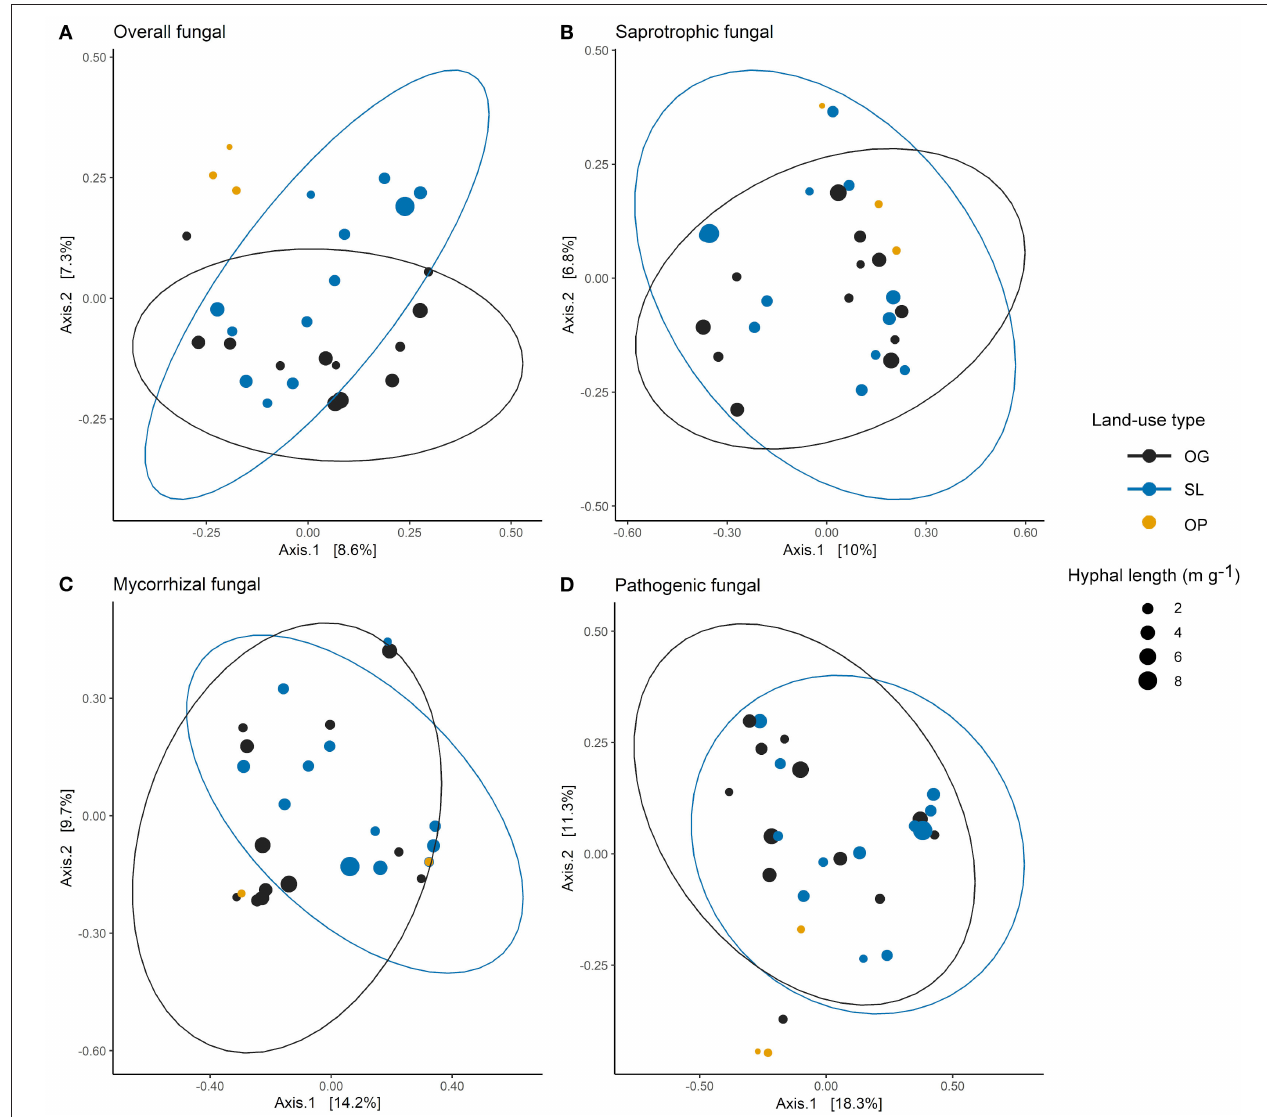
FIGURE 2 | Principle coordinates analysis (PCoA) ordination of (A) overall, (B) saprotrophic, (C) mycorrhizal and (D) pathogenic mycelial fungal community Bray-Curtis dissimilarities across old-growth (OG) and selectively logged (SL) lowland dipterocarp rainforest and oil palm plantation (OP) in Sabah, Borneo. Points are scaled by hyphal length indicating mycelial production. Ellipses represent t -distribution confidences for OG selectively SL forest. Ellipses are not included for OP samples due to number of samples ( n = 3). For mycorrhizal fungal community dissimilarities (C) , two OP points are indistinguishable (hyphal length values 0.24 and 0.84m g − 1 respectively) due to sharing the same PCoA scores for Axes 1 and 2 (coordinates: 0.32, −